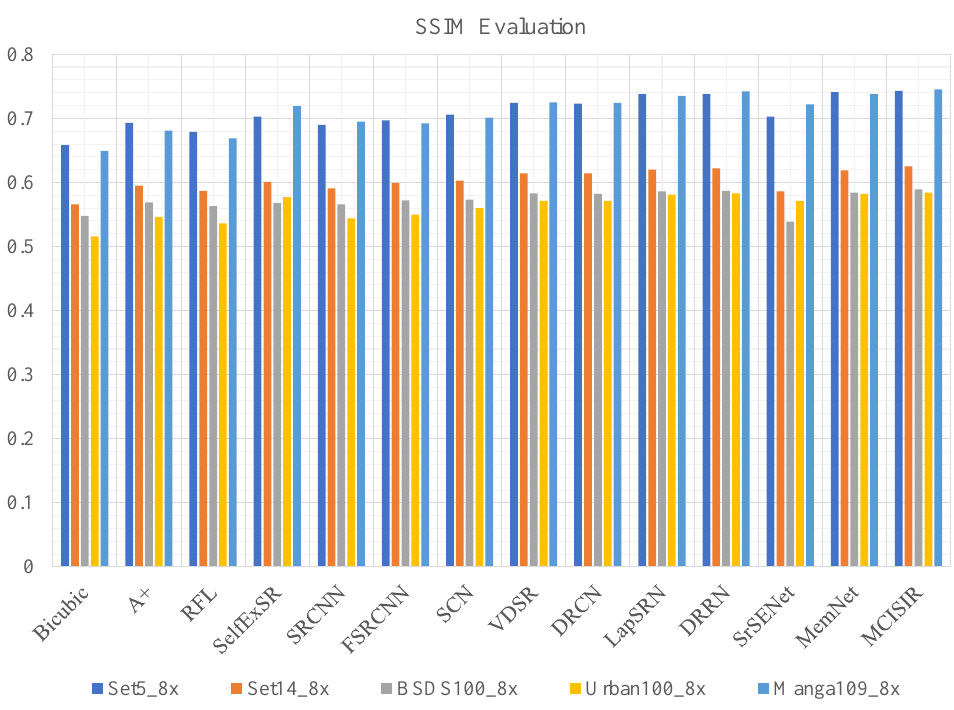
Figure 13. Plot the SSIM of all publicly available test image datasets versus different algorithms on enlargement scale factor 8 × .